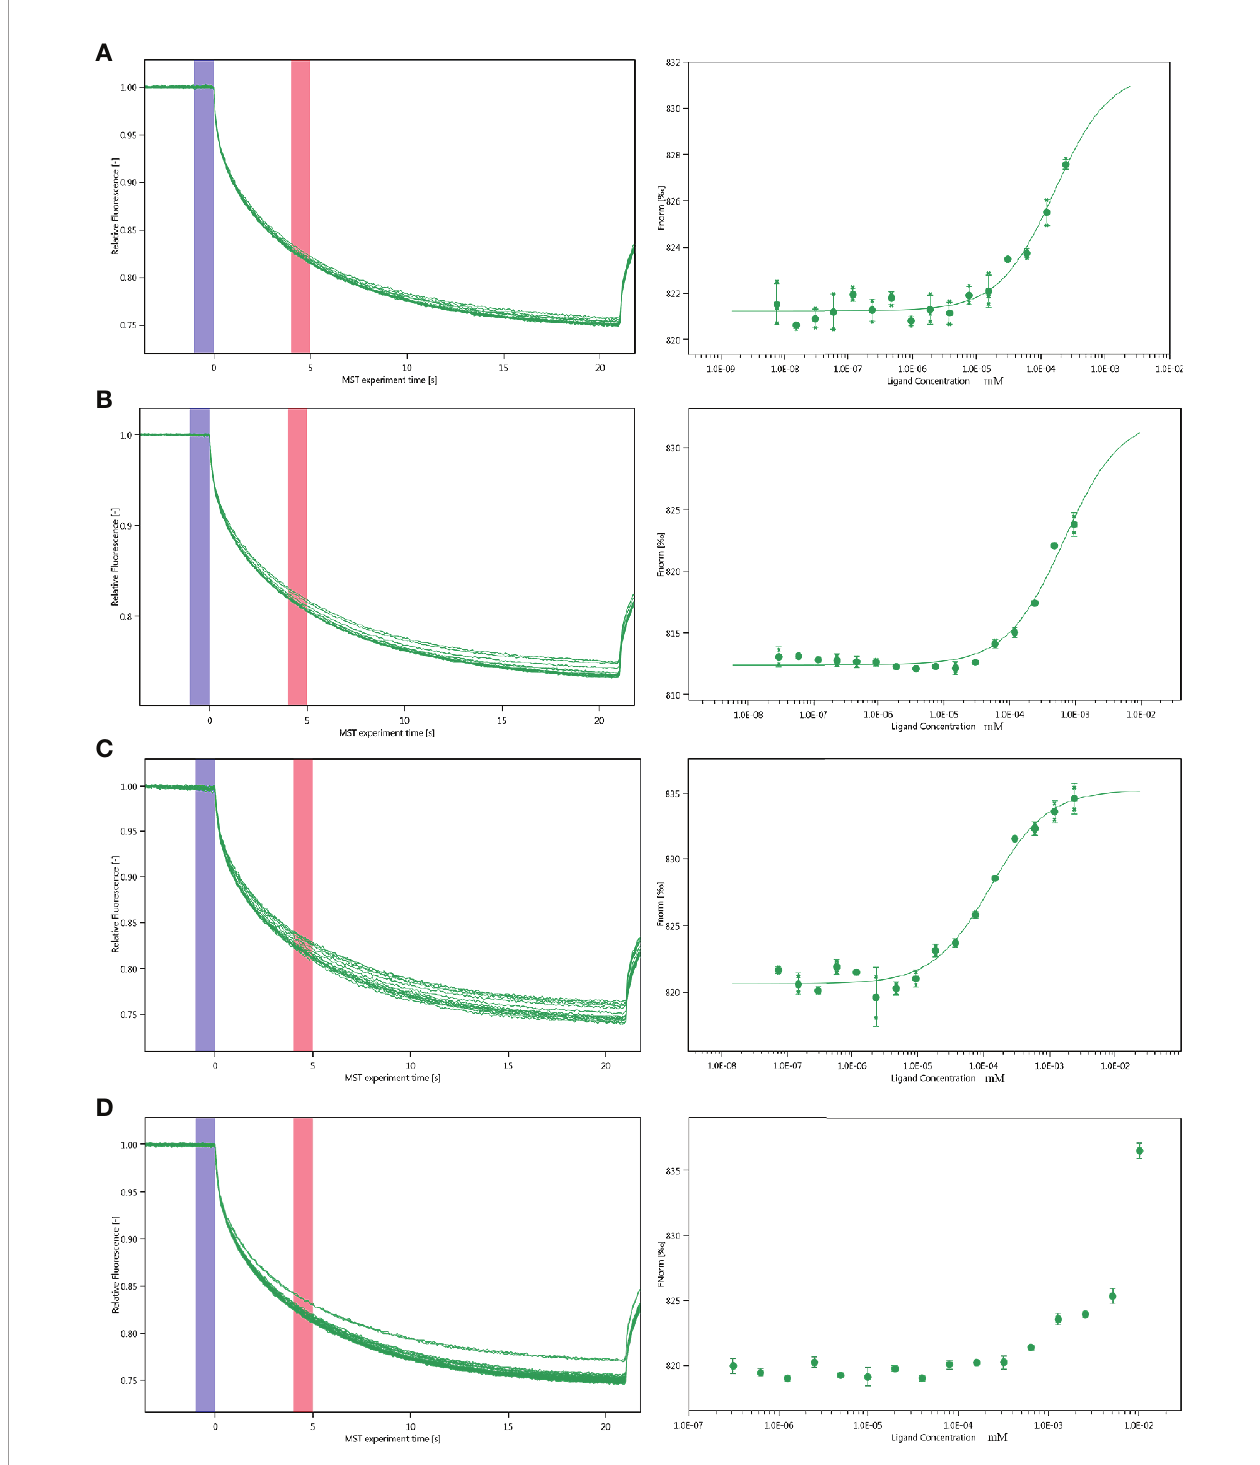
FIGURE 5 | Molecular interactions of esculetin by NT. 115 analysis. MST time traces of esculetin at 16 different concentrations, from 7.48 × 10 − 6 to 0.245 mM (A) PGK2 (5.32 µM), Kd=161.0 ± 63.28 nM (B) GPD2 (0.02 µM), Kd=666.14 ± 196.12 nM (C) GPI (0.5 µM), Kd=127.36 ± 22.36 nM (D) BSA (0.945 µM), failed, MST signal measured 30 s after heating turned on